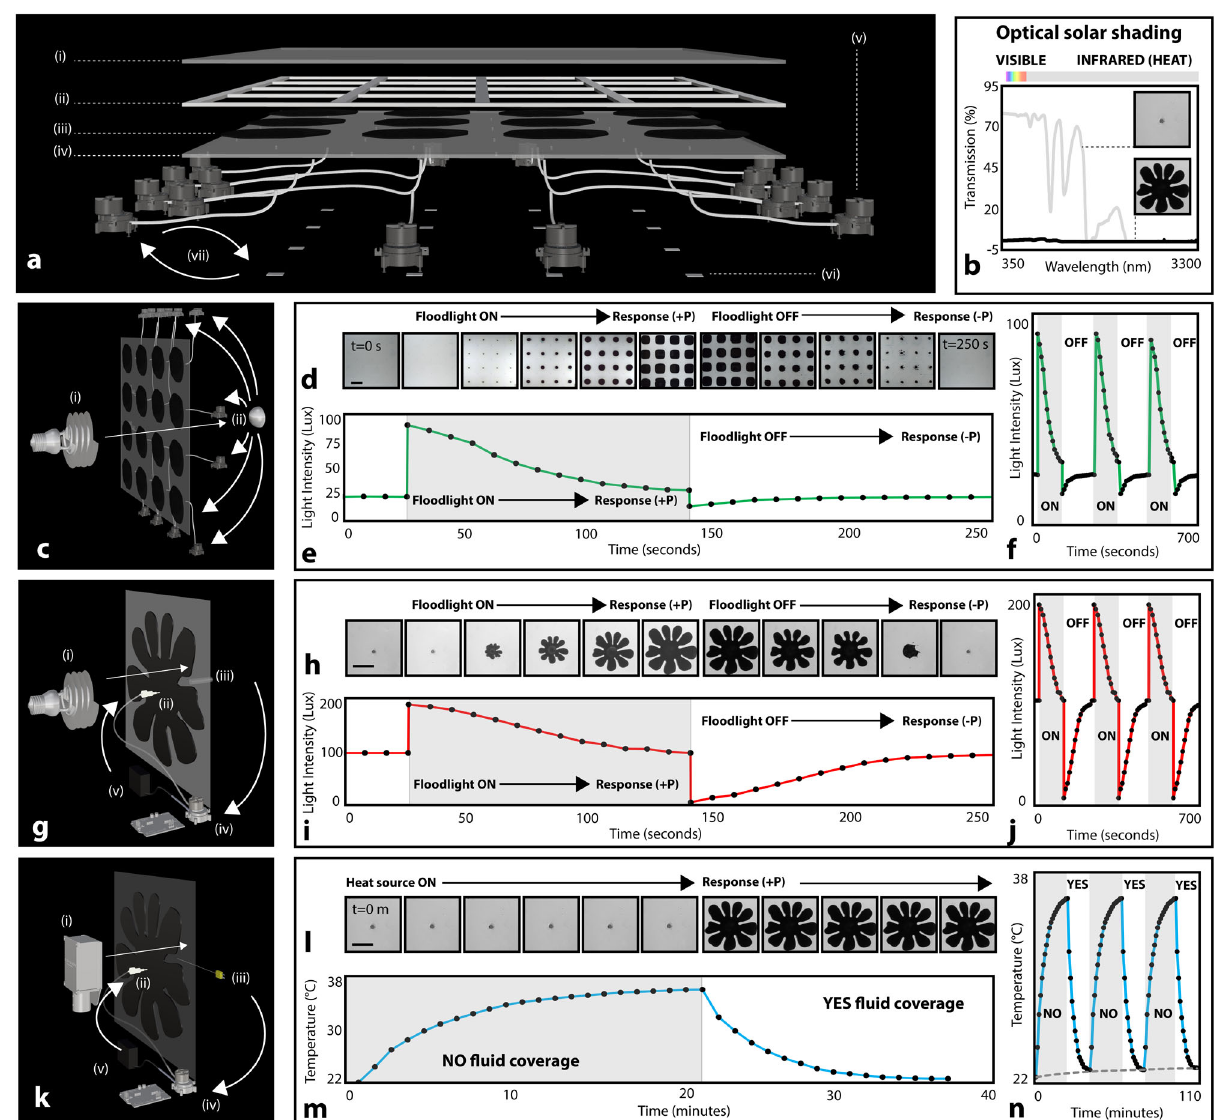
Fig. 3 Optical and thermal characterization of responsive pigment dispersal for single and multicell system. a Multicell device: (i) outer expandable layer; (ii) adhesive and gasket; (iii) fl uidic pigment layer; (iv) inner rigid plate; (v) digitally-driven peristaltic pump; (vi) light intensity sensor; (vii) feedback loop between sensor and pump. b Optical spectrum for pigment fl uid (aqueous carbon black, black line) and castor oil (grey line). c Experimental setup for data in ( d – f ): (i) light source; (ii) single light sensor. d Images showing dispersal and contraction sequence for multicell devices as a response to light. Scale bar is 10 cm. e Light intensity as a function of time for single sequence in ( d ). f Three sequences of ( e ) to demonstrate consistency. g Experimental setup for data in ( h – j ): (i) light source; (ii) dispersed pigment fl uid layer; (iii) light sensor; (iv) signal to digital peristaltic pump; (v) control over pigment fl uid dispersal. h Images showing dispersal and contraction sequence for single-cell device as a response to light. Scale bar is 15 cm. i Light intensity as a function of time for single sequence in ( h ). j Three sequences of ( i ) to demonstrate consistency. k Experimental setup for data in ( l – n ): (i) heat source; (ii) dispersed pigment fl uid layer; (iii) thermocouple measuring interior plate; (iv) signal to digital peristaltic pump; (v) control over pigment fl uid dispersal. l Images showing dispersal and contraction sequence for single-cell facade as a response to temperature. Scale bar is 15 cm. m Temperature as a function of time for single sequence in ( l ). n Three sequences of ( m ) to demonstrate consistency. Grey line represents control curve, where pigment fl uid is dispersed and maintained statically across all three